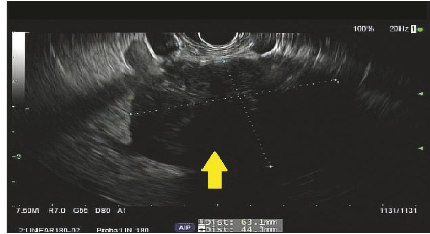
Figure 2: EUS showing irregular, hypoechoic left adrenal mass measuring 63 × 44 mm.